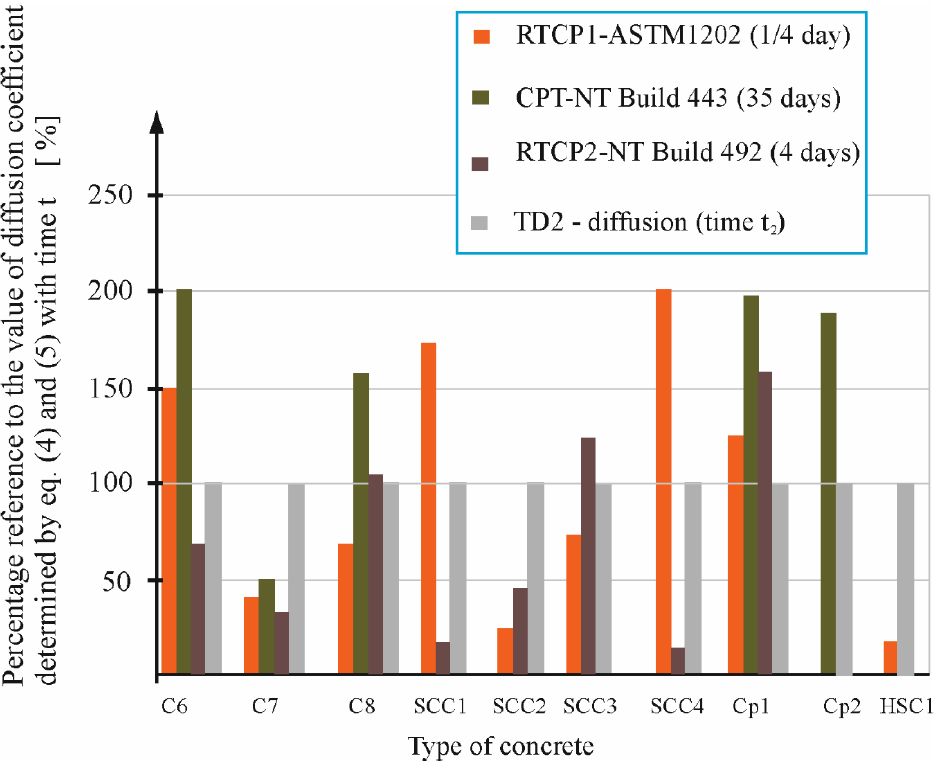
Figure 11. Percentage reference of the value of diffusion coefficient determined under the ASTM C1202-97 [6] (RCPT1), NT BUILD 492 [14] (RCPT2), and NT BUILD 443 [5] (CPT) standard to the value of diffusion coefficient (TD2) determined by Equations (4) and (5) with time t 2.